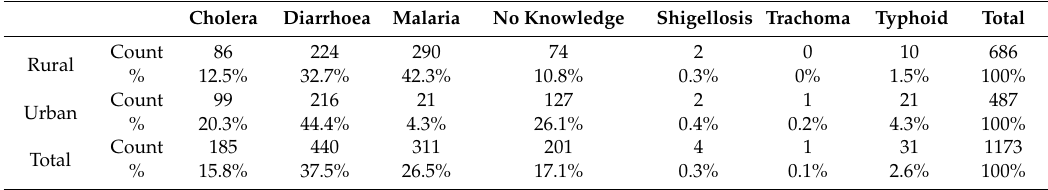
Table 4. Students’ knowledge on WASH-diseases prevention